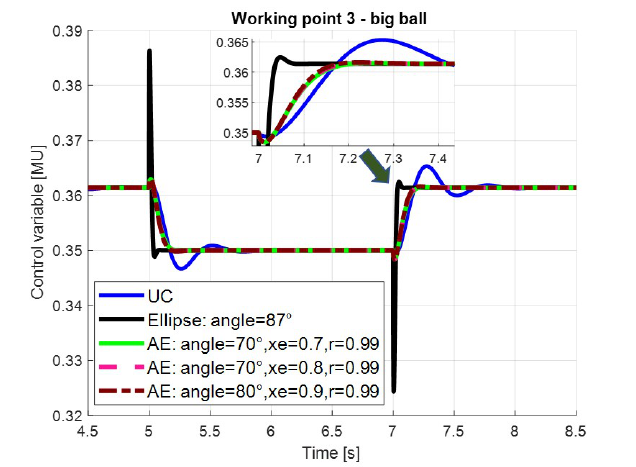
Figure 9. Control variable responses simulated on nonlinear model for the 3rd working point (big ball) with the proposed pole-placement controllers according to legend.